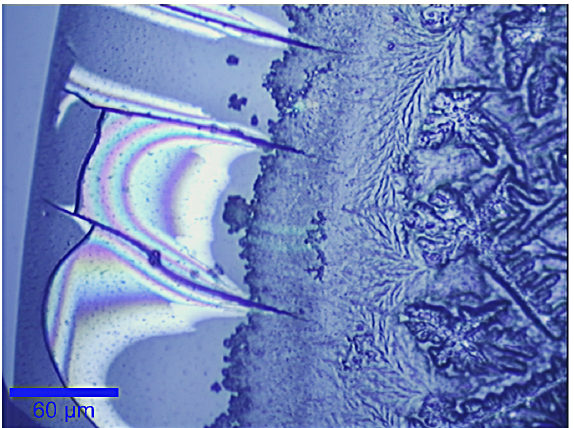
Figure 1. Bright-field image of a detail (edge) of a drying droplet of tear sample examined in this study. The scale bar is 60 µ